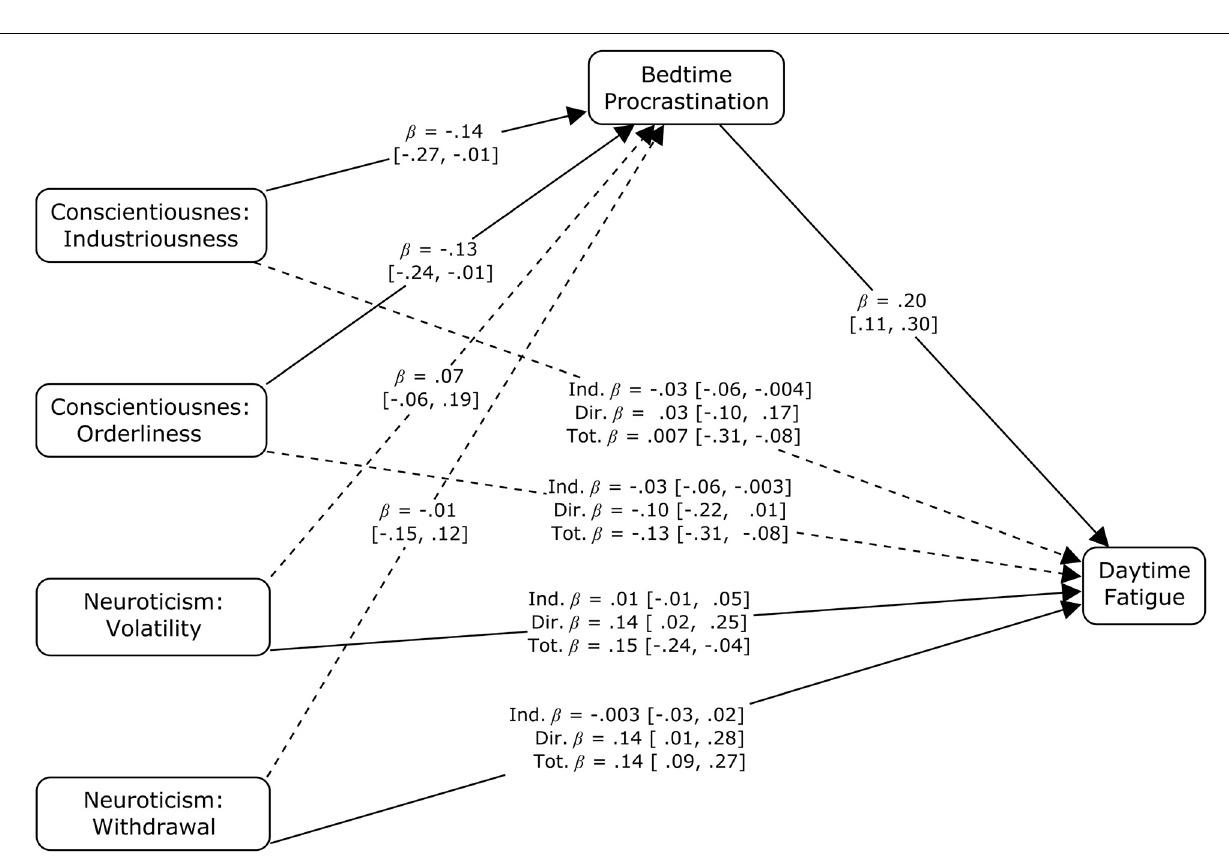
Frontiers in Neuroscience |